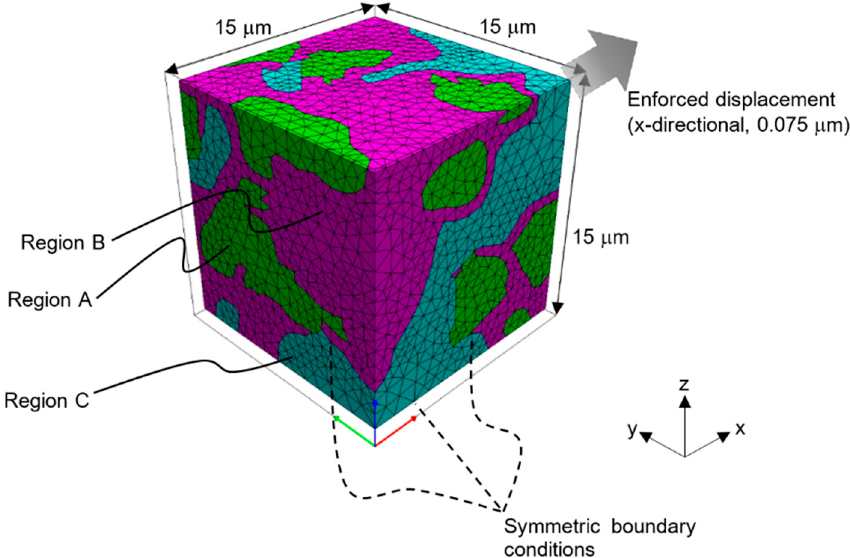
Figure 2. Cu-IMC-resin model of size 15 µ m for finite element (FE) analysis, which is based on 3D image reconstruction. The model comprises Cu (green), IMC (pink), and resin (light blue).